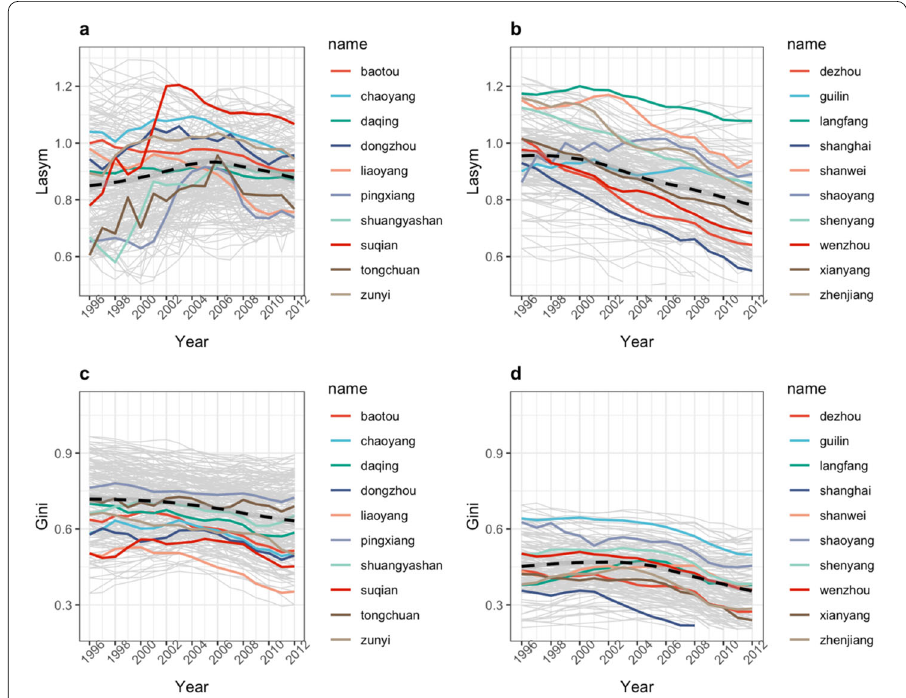
Figure 3 The changes of Gini and Lasym indices over time for 20 randomly chosen Chinese cities. ( a ) and ( c ) shows the Lasym and Gini indices of 10 randomly chosen cities whose densities are smaller than the density at 1025 people/km 2 where the peak of the inverted U-shaped curve emerged in 2010. These cities are called the pre-peak cities. ( b ) and ( d ) shows the Lasym and Gini indices of another 10 randomly chosen cities whose densities are larger than 1025 people/km 2 . These cities are called the post-peak cities. Smooth curves are added using black dashed